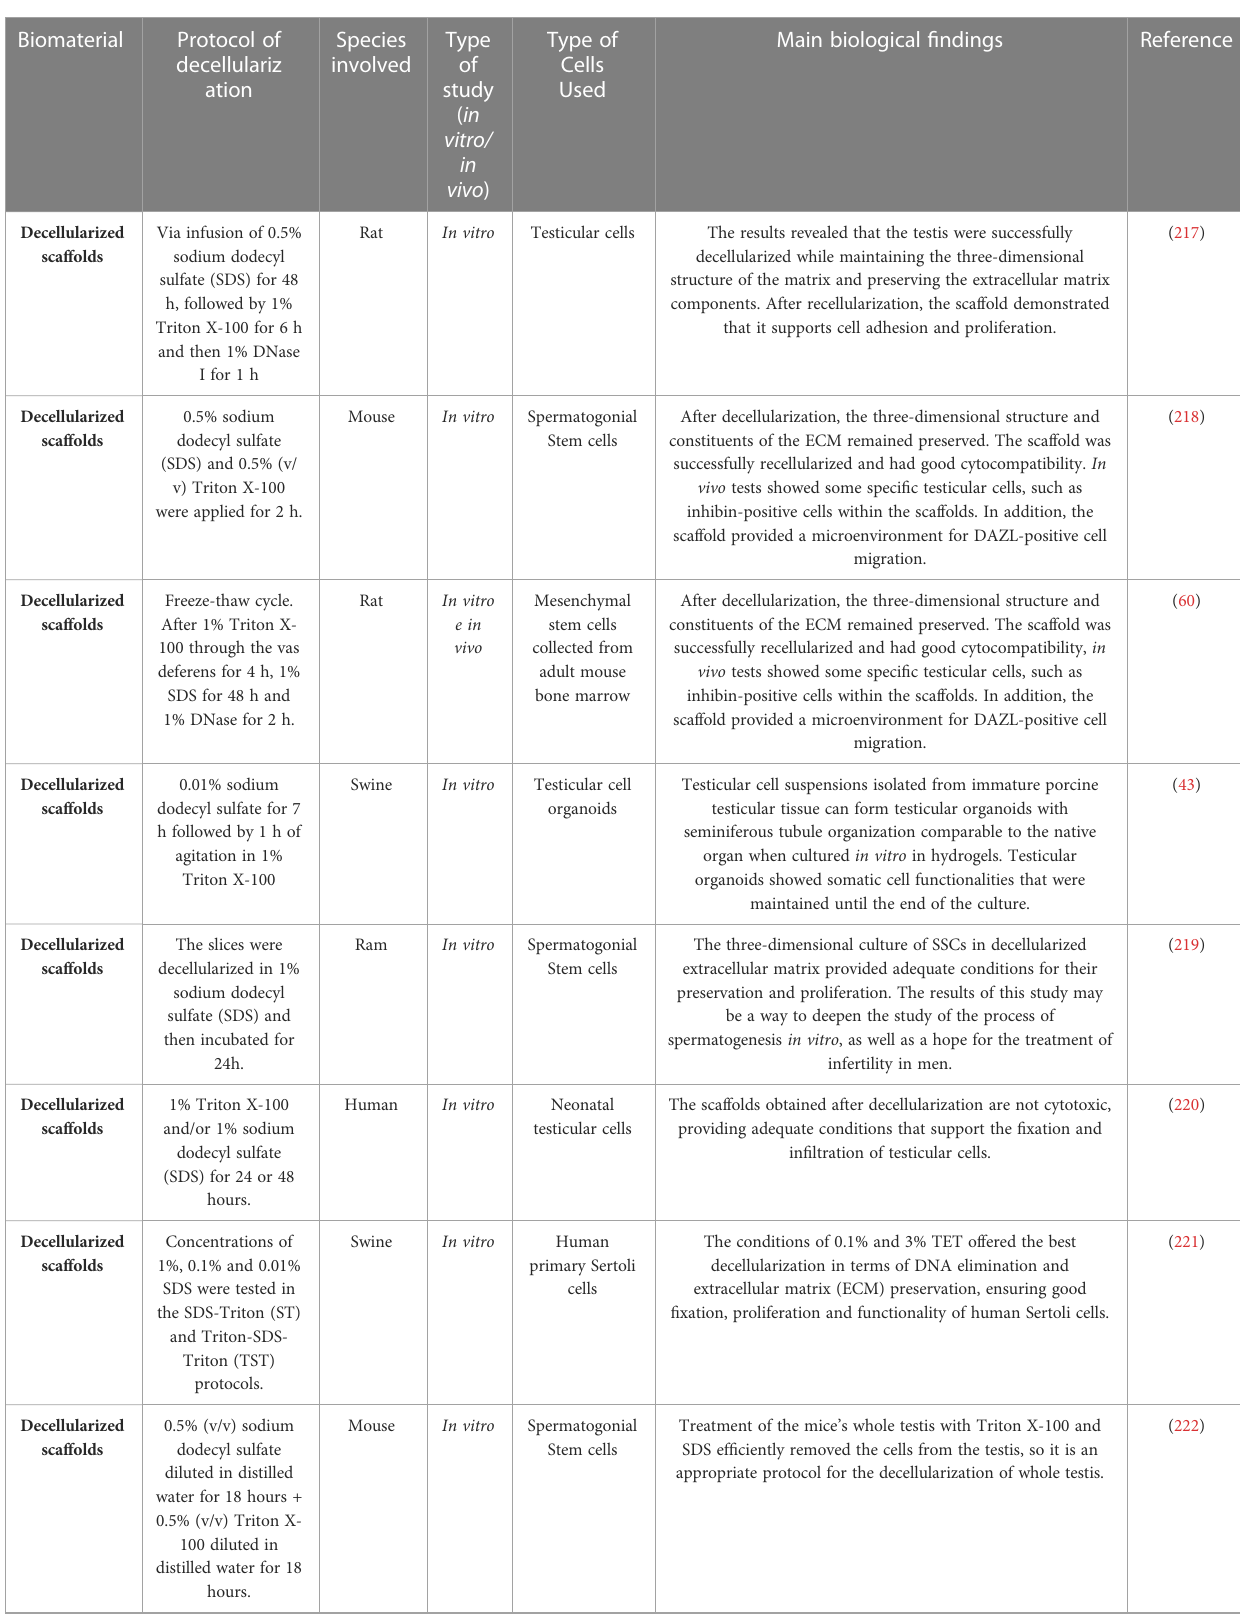
TABLE 4 Decellularization studies to generate scaffolds for testicular